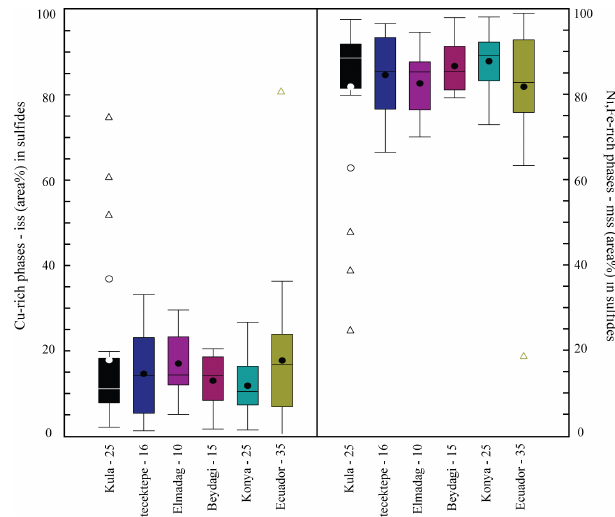
Figure 8. Box plot comparison of the Cu and Ni content (wt%) resulting from individual mineral analyses measured by EPMA for the different sulfide types characterising each study area. The cen- tral box is in the middle 50% of the data (total number of mea- surements considered is noted in parenthesis on the x axes). The line and dots in the box represent the median and mean value for each box and sulfide type, respectively (see values in Table 1). The outliers are further than 1.5 (the 75th percentile is on top of the box, and the 25th percentile is at the bottom of the box), and the whiskers are the extreme values that are not outliers. Note that only Beydagi, Konya, and Ecuador which, are the three ar- eas associated with porphyry deposits, display the highest in Cu values of Type 3 and 4 sulfides. The stoichiometry of common sulfide mineral phases has been depicted for Cu and Ni (wt%) contents according to mindat.org. For the dataset, see Table 4 at https://doi.org/10.6084/m9.Figshare.8230787.